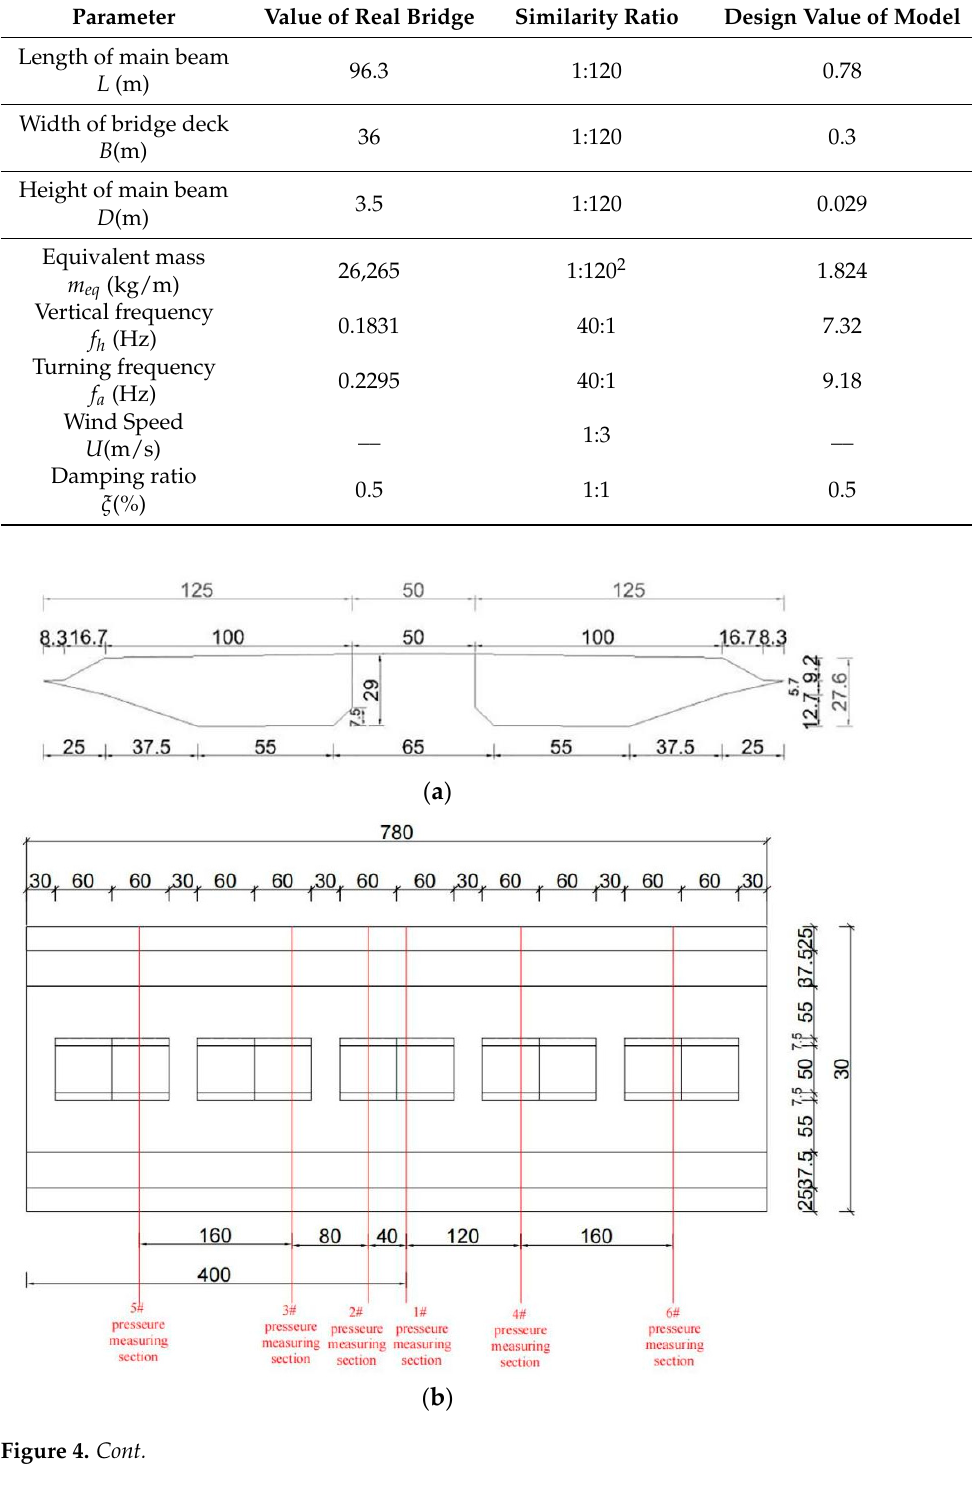
Table 1. Design parameters of Sepilt double-box beam section model.